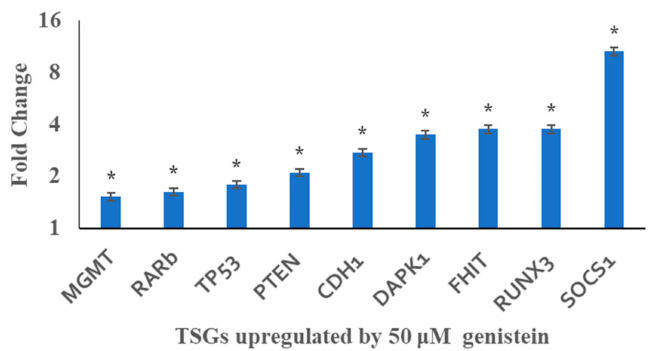
Figure 6. qRT PCR analysis against the e ff ect of genistein on TSG expression in HeLa cells. Genistein (50 µ M) significantly increased the levels of TSG expression. Fold change was calculated by ∆∆ CT analysis in comparison with the untreated control after normalization with housekeeping gene. The values are means ± SD of three independent experiments (* p ≤ 0.05).